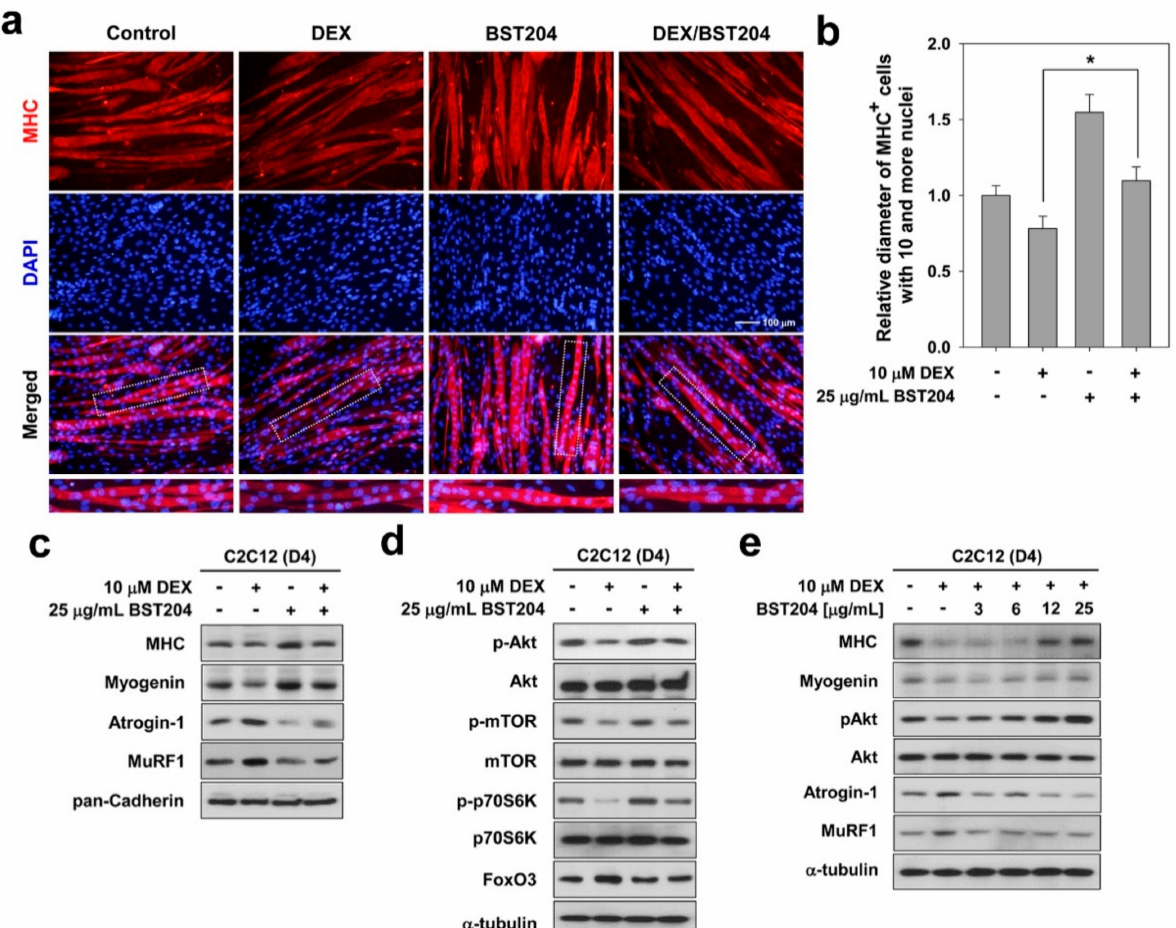
Figure 2. BST204 prevents dexamethasone (DEX)-induced myotube atrophy through Akt activation. ( a ) C2C12 cells were induced to differentiate in DM for 3 days, followed by the treatment with 10 µ M DEX along with vehicle or 25 µ g/mL BST204 for 1 day. These myotubes were then subjected to immunostaining for MHC expression (red) and DAPI to visualize nuclei (blue). ( b ) Quantification of average myotube diameter from data shown in panel a . Significant difference from DEX-treated group, * p < 0.05. ( c ) C2C12 cells were induced to differentiate in DM for 3 days, followed by the treatment with 10 µ M DEX along with vehicle or 25 µ g/mL BST204 for 1 day. Cell lysates were subjected to immunoblotting analysis. ( d ) Cell lysates from panel c were subjected to immunoblotting analysis. ( e ) C2C12 cells were induced to differentiate in DM for 3 days, followed by the treatment with 10 µ M DEX along with vehicle or the indicated concentration of BST204 for 1 day. Cell lysates were subjected to immunoblotting analysis. All immunoblotting experiments were repeated three times with similar